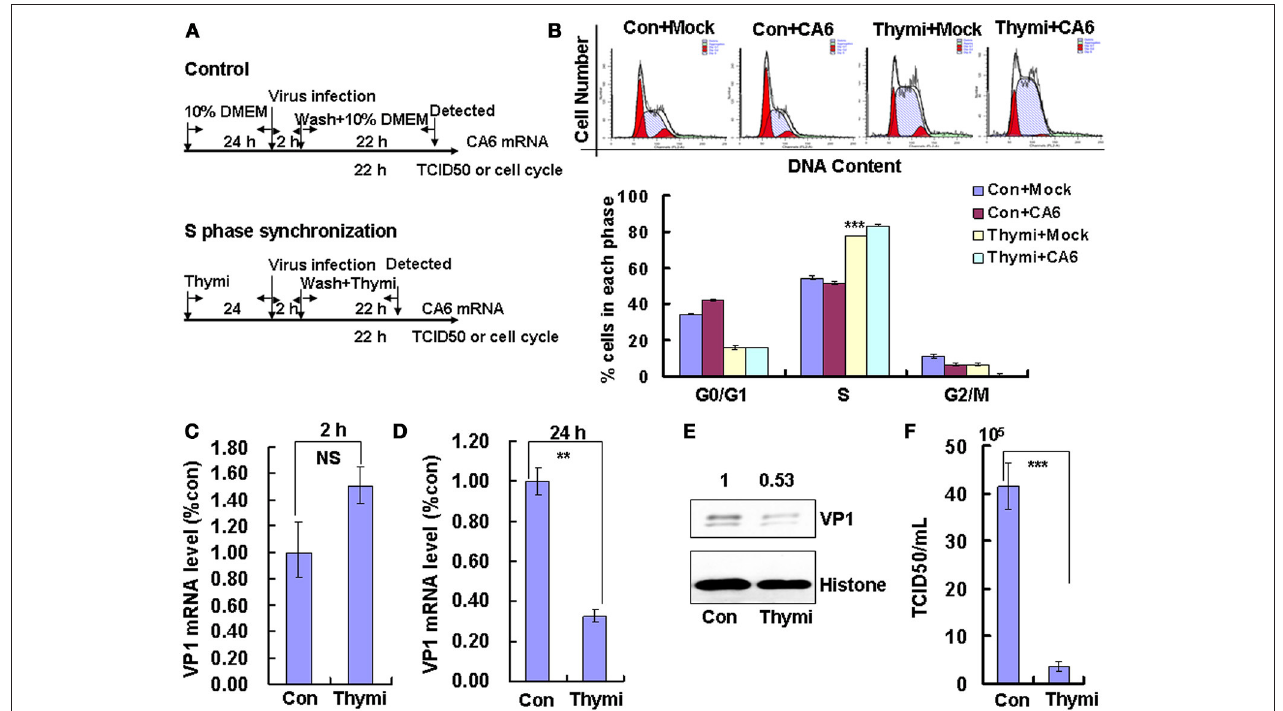
FIGURE 3 | S phase-synchronization inhibits viral production. (A) RD cells were treated without (Con) or with 0.85mM thymidine (Thymi) for 24h for S phase synchronization. Then, RD cells were infected with mock (Mock) or with 1 MOI of CVA6 (CVA6), after 2h infection, and cells was re-treated with fresh culture medium or 0.85mM thymidine for another 24h. (B) Top panel: Flow cytometry determined the cell cycle profiles after culture in control medium (Con) or thymidine (Thymi)-containing medium for 24h. Bottom panel: The histograms indicating the cell cycle distribution were analyzed by the ModFit LT program. *** P < 0.001 (Thymi + Mock vs. Con + Mock). (C,D) Intracellular CVA6 genomic RNA levels were detected in RD cells with or without thymidine by quantitative real-time PCR at 2h (C) or 24h (D) post-infection. The results were standardized using GAPDH mRNA as a control and normalized to 1.0 in Con cells. (E) The expression of VP1